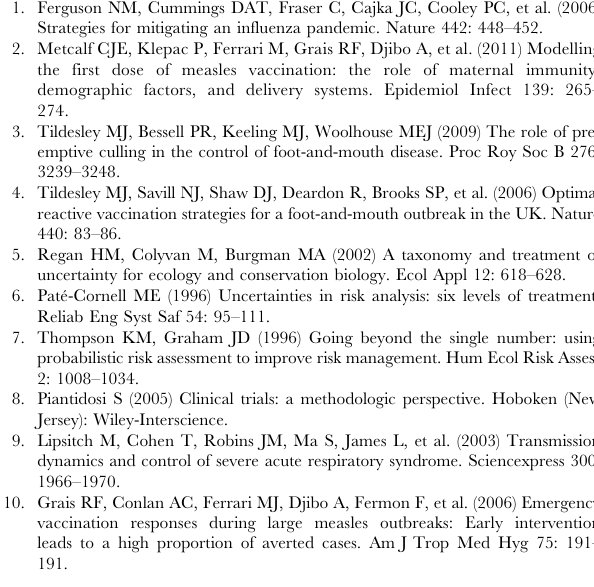
Table S1 Cost projections (in millions of £ ) for each two-stage intervention strategy for each kernel model. (DOCX) Table S2 Expected cost projections (in millions of £ ) of each first-stage intervention, conditional on the assump- tion that model uncertainty is resolved after 1 month and the second-stage action is taken as that intervention that minimizes costs under the true model. Table S3 Parameterization of the age distribution of susceptibles for three age distribution models. (DOCX) Text S1 Additional methods and model descriptions. (A) Description of the Warwick FMD model. (B) Interpretation of the EVPI table. (C) Expected value of an adaptive strategy. (D) Description of the measles outbreak model. (E) Alternate objective formulations to reflect risk tolerance for